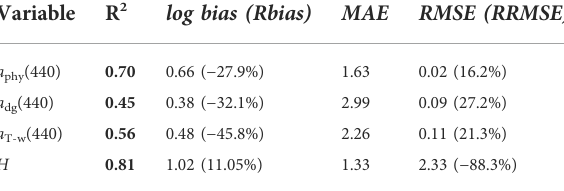
Bold values represent statistically signi fi cant results ( p -value <